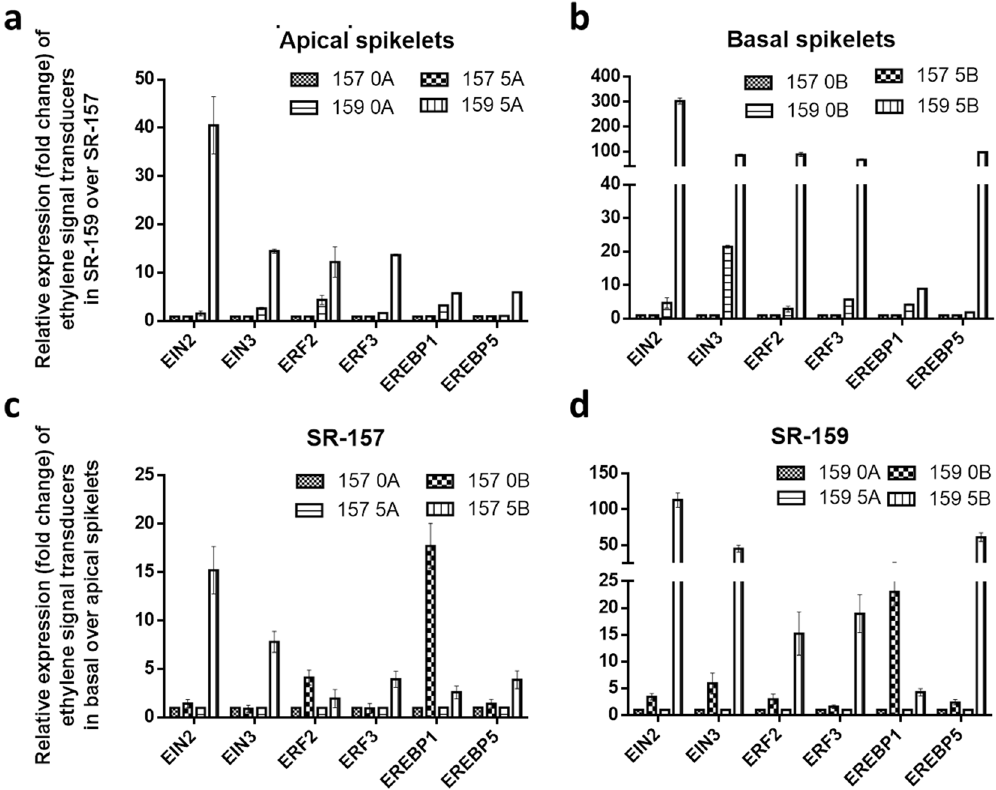
Figure 8. Relative expression (in fold change) of ethylene receptor genes ERS1, ERS2, ETR2, ETR3 and ETR4 in the apical and basal spikelets of the panicle of high sterile (SR-159) over low sterile (SR-157) rice genotypes and in the basal over apical spikelets of SR-157 and SR-159 analysed by Real Time PCR (qRT-PCR). The data are means of three replicates and vertical bars represent ± SD values (n =